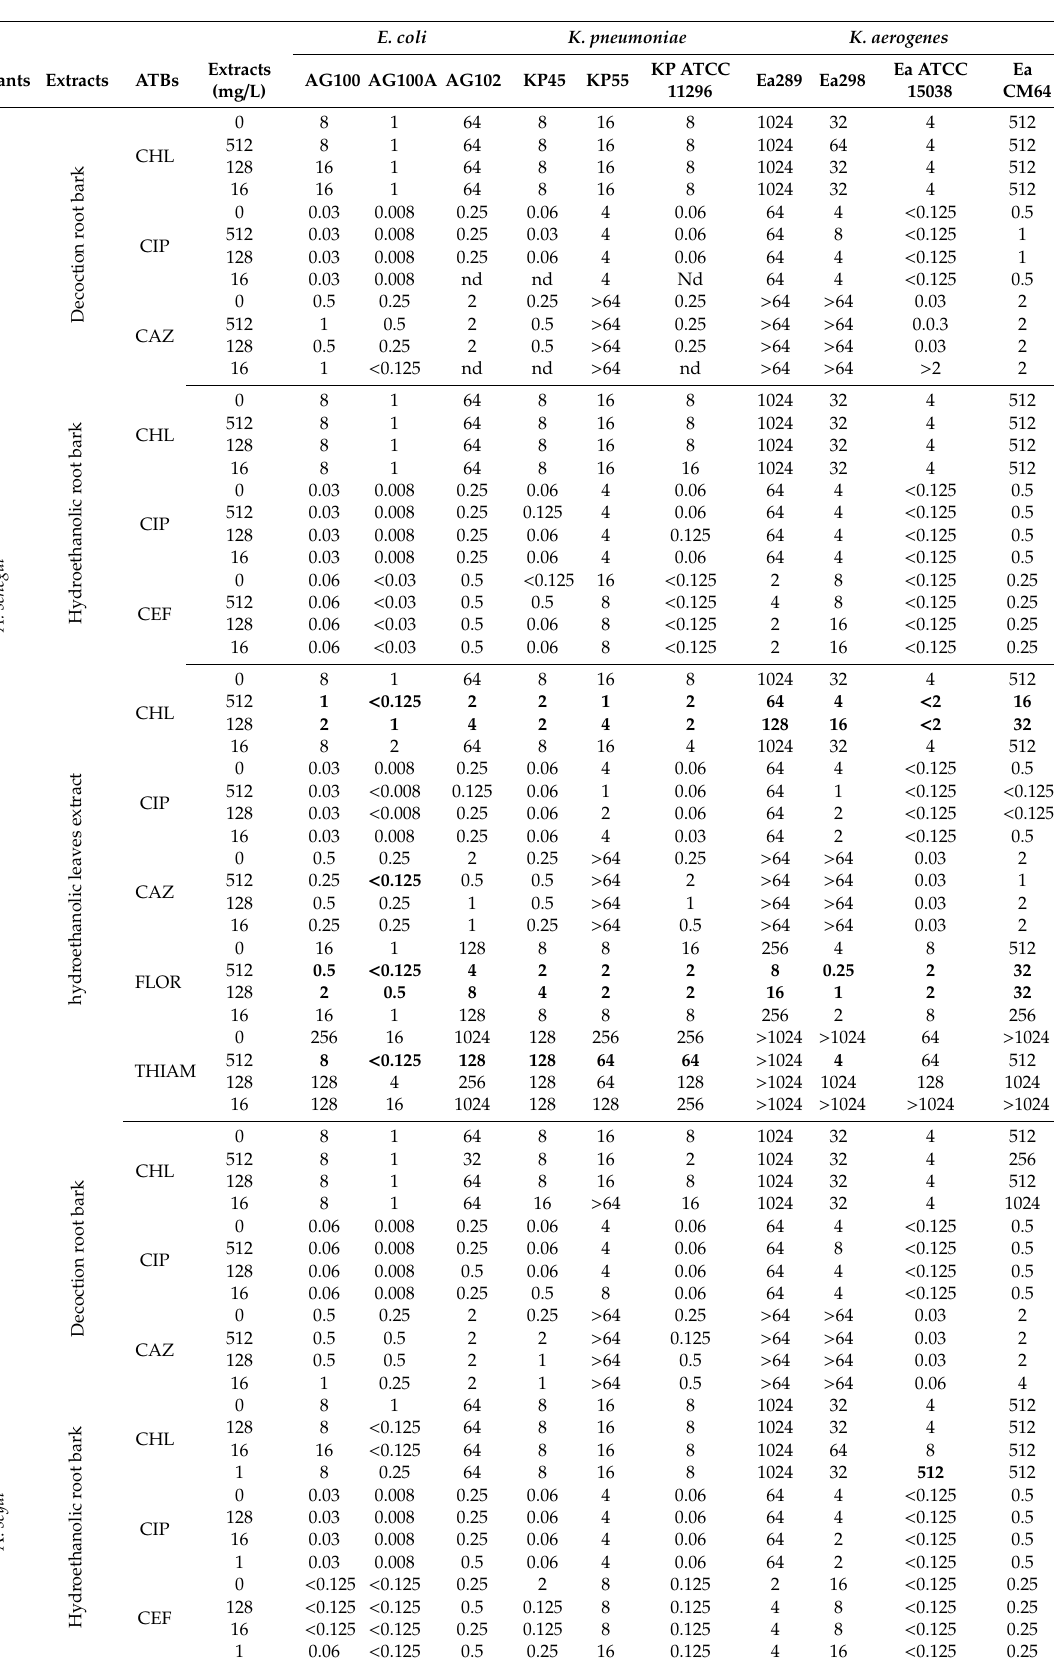
Table 4. MIC of antibiotics associated to extracts at various